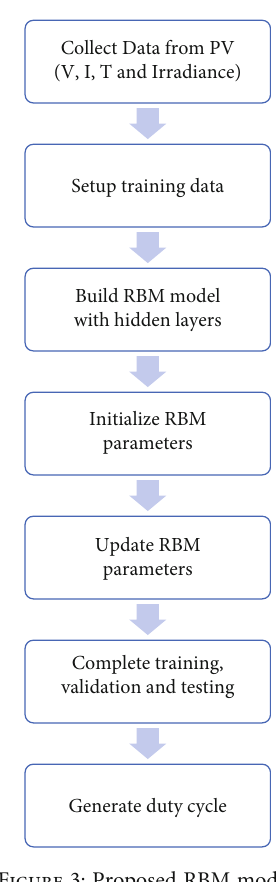
Figure 3: Proposed RBM